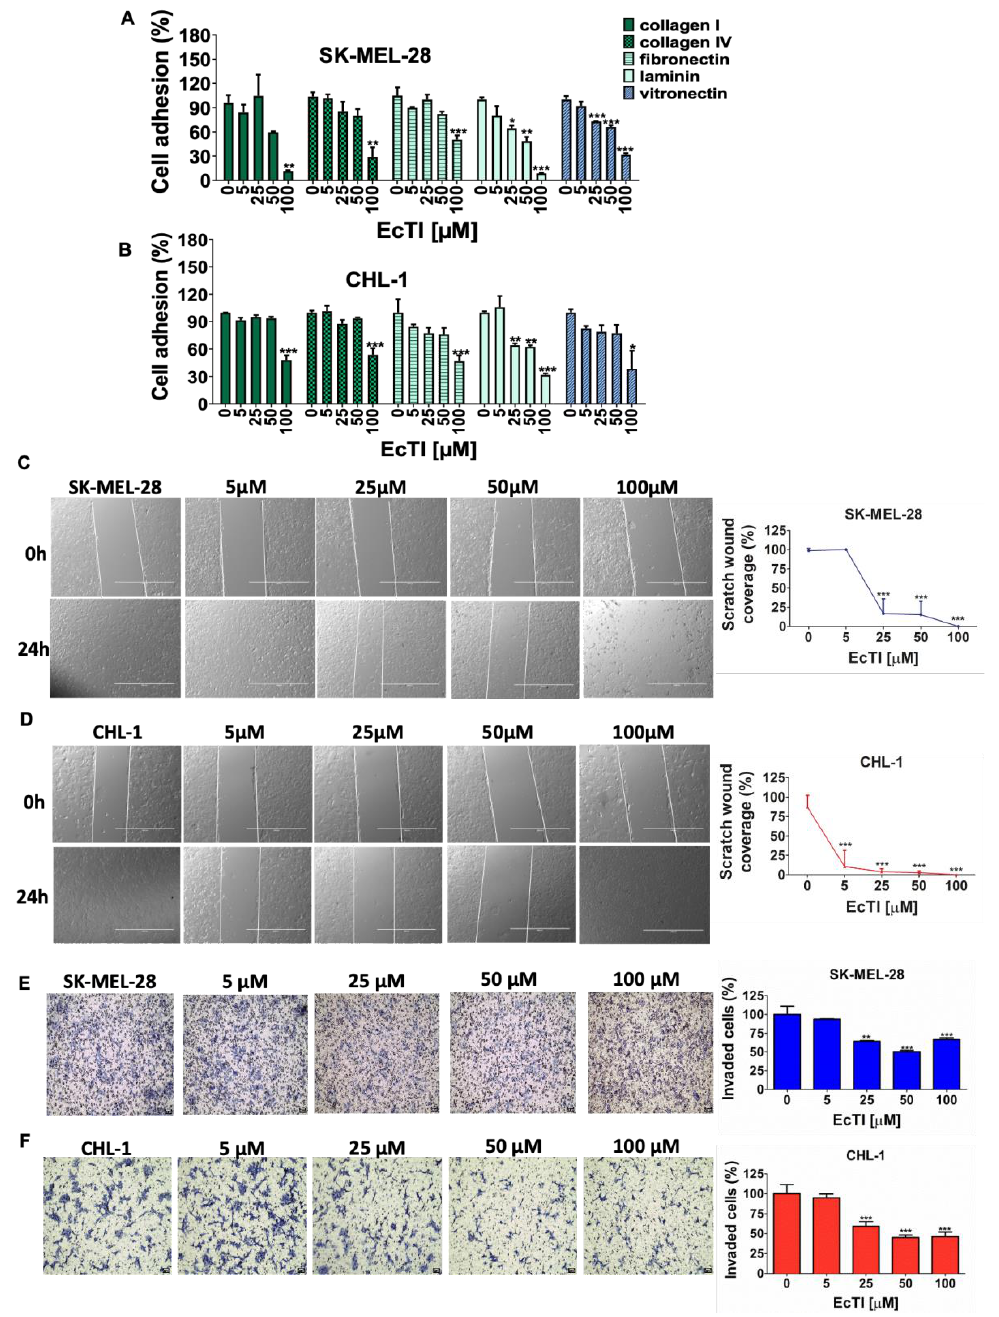
Figure 2. Cell adhesion, migration, and invasion. The effects of EcTI on cell adhesion of SK-MEL-28 ( A ) and CHL-1 ( B ) cells after pre-incubation of matrix molecules such as collagen I and IV, fibron- ectin, laminin, and vitronectin in the presence of increasing concentrations of EcTI (5, 25, 50, and 100 µM) show reduced interactions between EcTI and all matrix molecules, particularly laminin and vitronectin. Cell migration was assessed using the scratching assay after EcTI incubation on mela- noma cells; a pronounced effect of above 70% was observed in SK-MEL-28 ( C ) and CHL-1 ( D ). The invasion assay was performed using the Boyden chamber technique with different concentrations of EcTI for 24 h; a superior reduction (25%) in the invasion capability of SK-MEL-28 ( E ) and CHL-1 ( F ) cells was observed (scale bar 20 µm). All percentage values were normalized to control cells